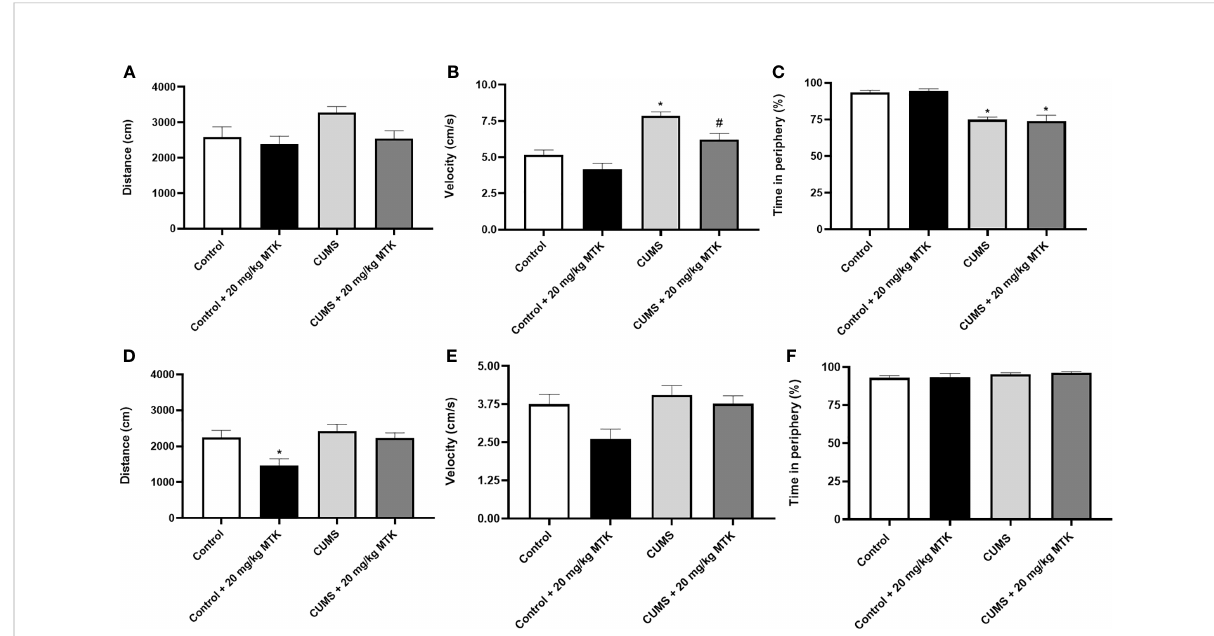
FIGURE 3 Effects of MTK on rats' behavior in the open fi eld test. Male (A-C) and female (D-F) rats were subjected to CUMS or control conditions for six weeks. During the last two weeks of the protocol, animals were treated (ip) with MTK 20 mg/kg or vehicle. On days 44 and 45, rats were placed for 20 minutes in an open fi eld arena; only the last 10 minutes of the session were assessed. The parameters that were analyzed are: total distance traveled (A, D) , mean velocity (B, E) , and the percentage of time spent in the peripheral zone (C, F) . Each column is the mean ± SEM of 12 to 18 rats per group. Using one-way ANOVA (with Benjamini-Hochberg false discovery rate) followed by Student ’ s t-test for normally distributed variables, and Kruskal-Wallis test (with Benjamini, Krieger and Yekutieli false discovery rate) for abnormally distributed variables, for speci fi c group comparisons: *p < 0.05 vs. Control + DMSO; #p < 0.05 vs. CUMS +